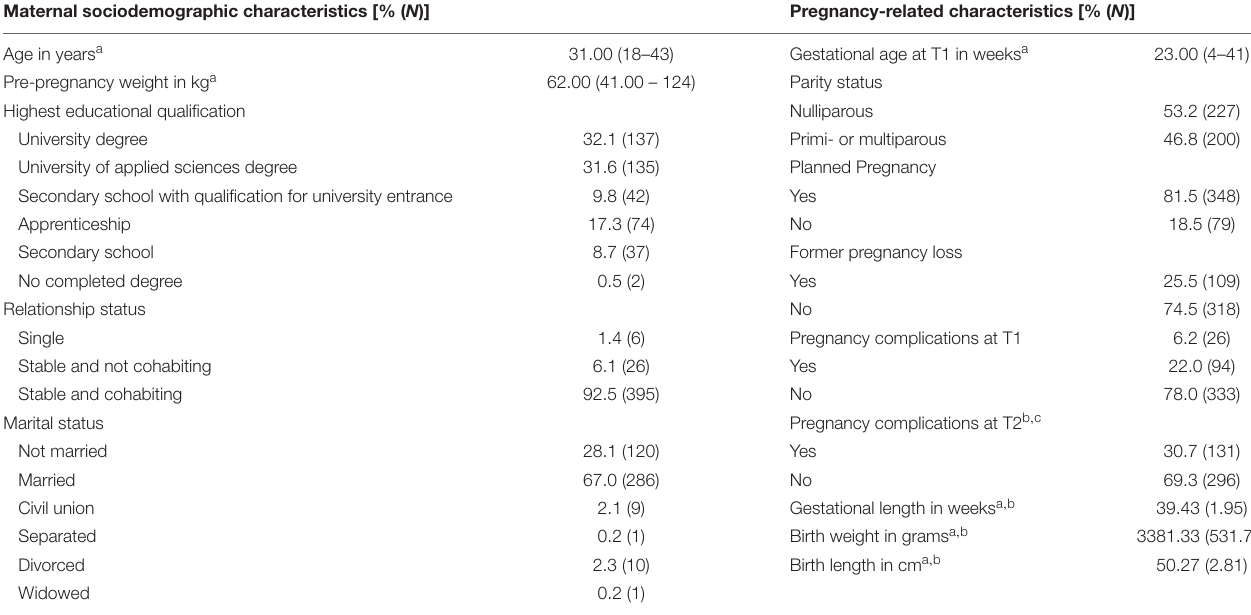
TABLE 1 | Descriptive statistics of